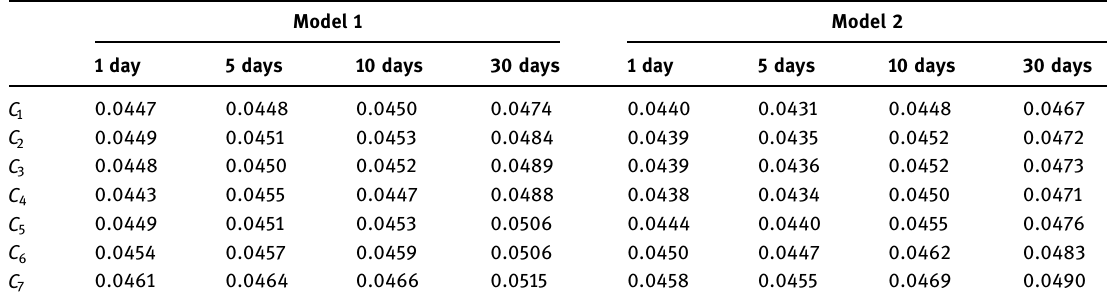
Table 5: RMSE for 1, 5, and 10 days ahead predictions in 30 - day out - of - sample window using 30/1/2017 – 18/2/2021